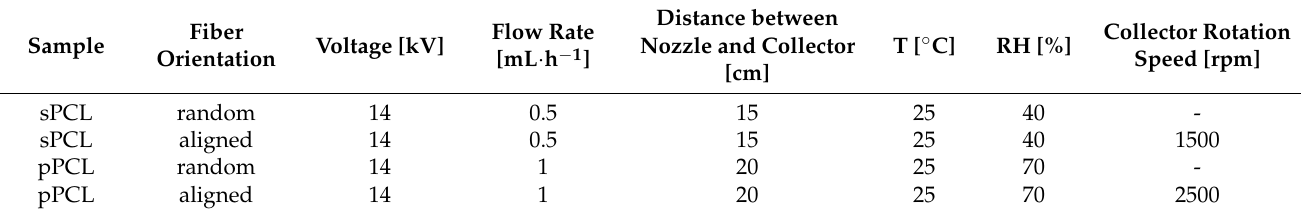
Table 1. Electrospinning parameters for smooth (sPCL) and porous (pPCL) fibers.